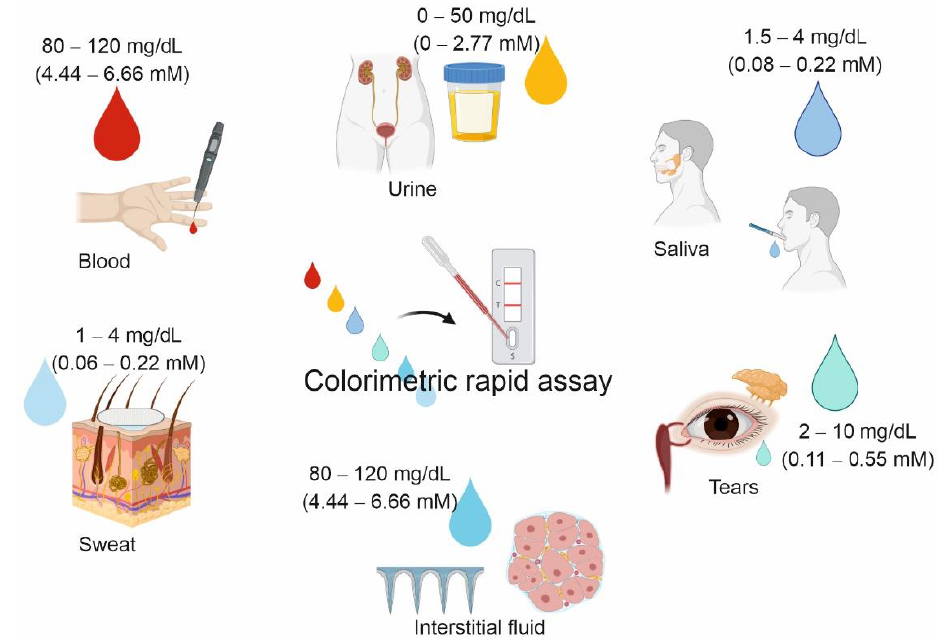
Figure 1. Scheme showing different biological fluids under investigation for their potential as glucose biosources in the development of home-testing systems and their relative physiological glucose concentration.